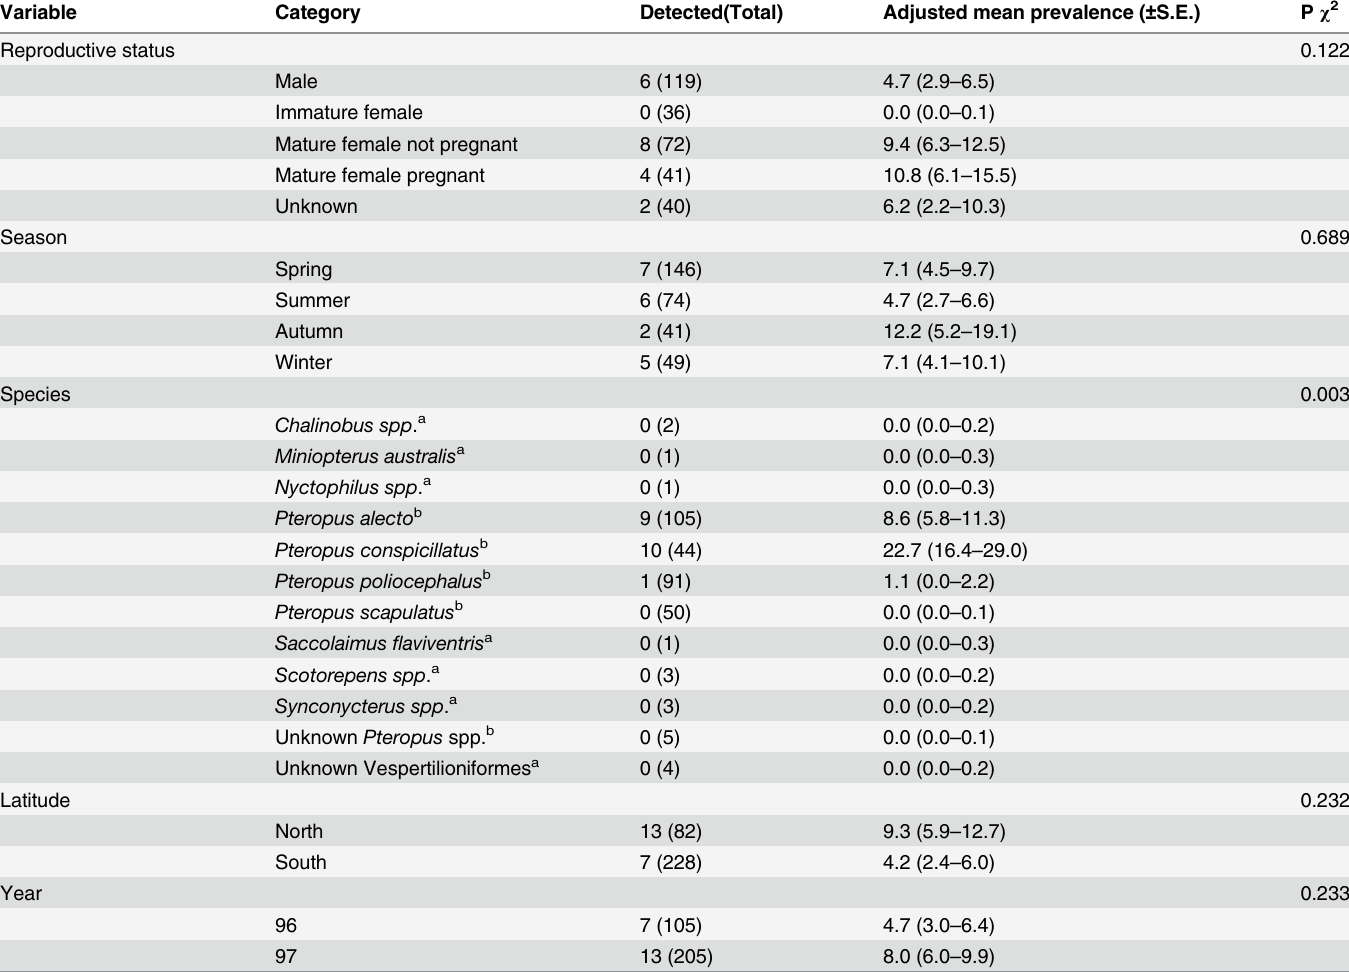
Table 1. Test results from RT-qPCR (n = 310) were subjected to a generalised linear model [19] under the Binomial distribution and logit link, using GenStat